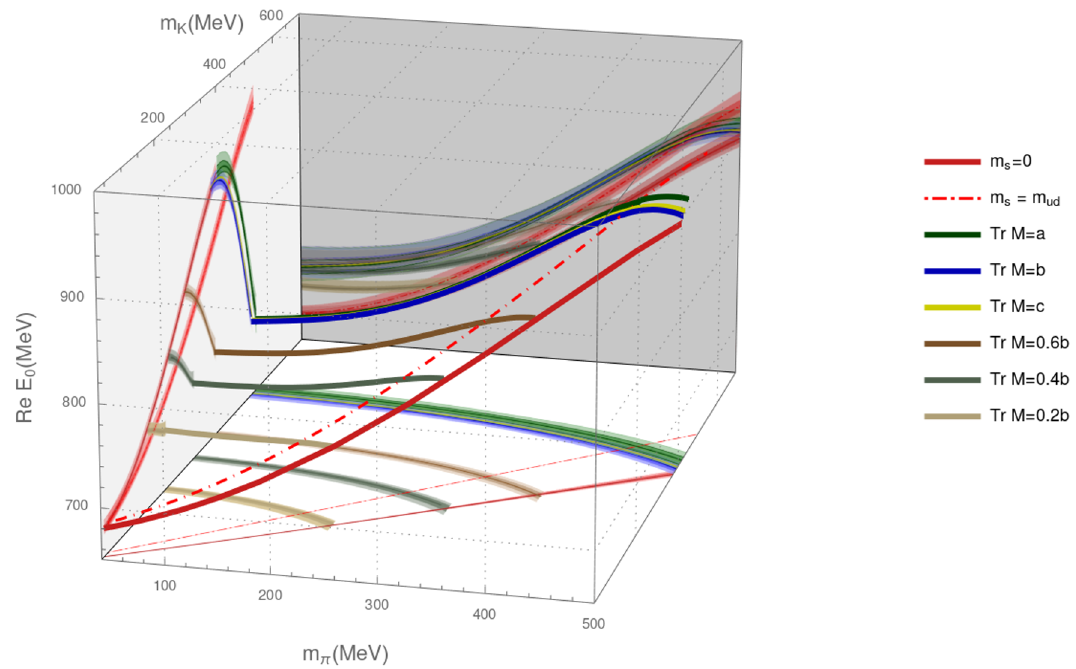
Figure 31 . The real part of the (cid:26) -meson pole position, Re E 0 , as a function of m (cid:25) and m K